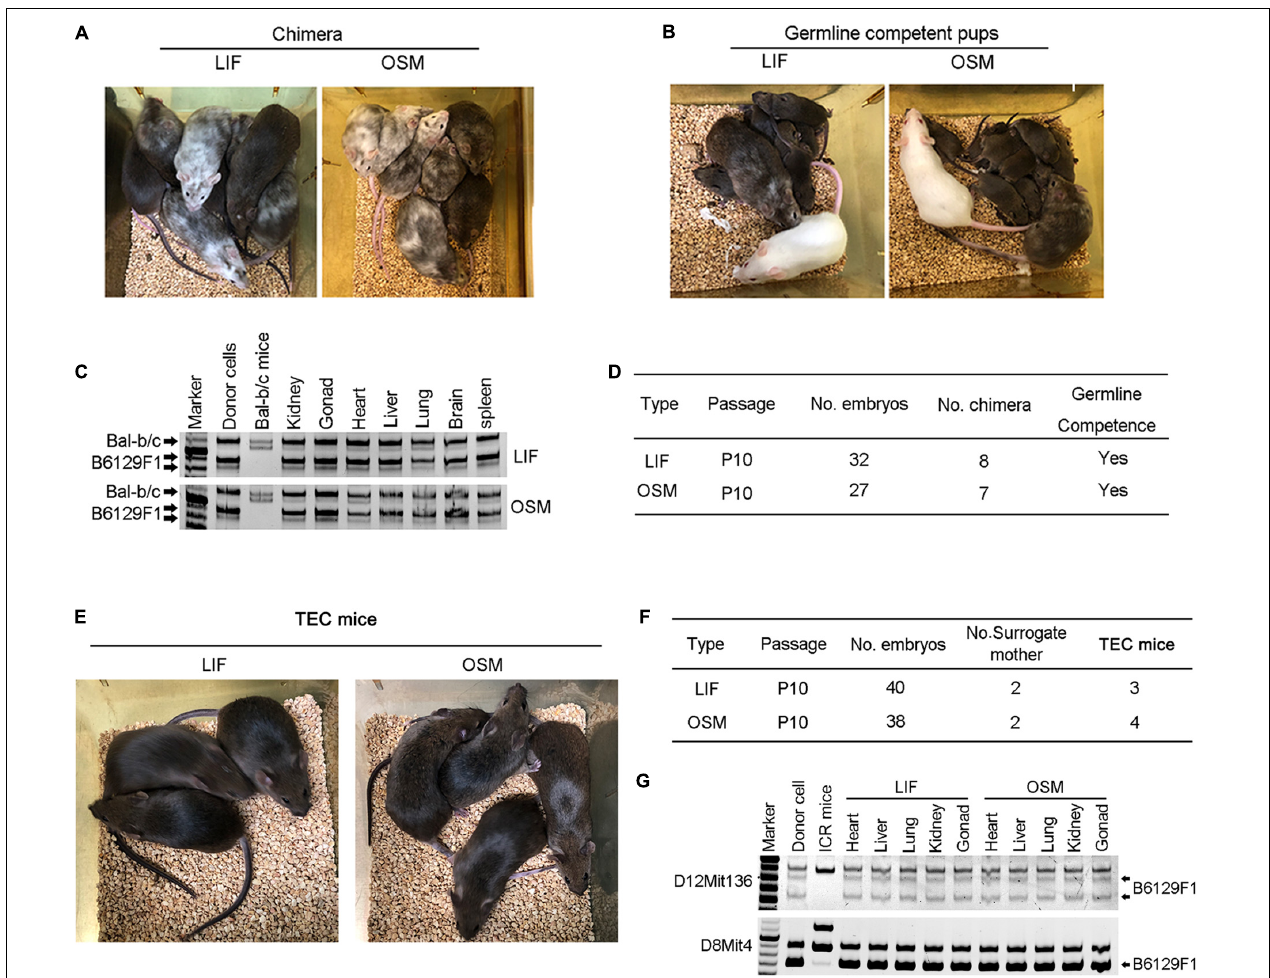
FIGURE 3 | Germline competence chimera and viable tetraploid complementation mice generated from ESCs cultured in OSM medium. (A,B) Chimera (A) and germline competency (B) of mESCs cultured in LIF and OSM medium by 4–8-cell embryo injection. Germline offspring was produced by mating chimeras with albino ICR mice. Albino Balb/c mice served as embryo donors, and pseudo-pregnant albino ICR mice as surrogate mother. (C) Genotyping analysis of chimeras by microsatellite primers D12Mit136. (D) Summary of 4–8-cell embryo injection of mESCs cultured in LIF and OSM medium. (E) Full-ESC mice generated from